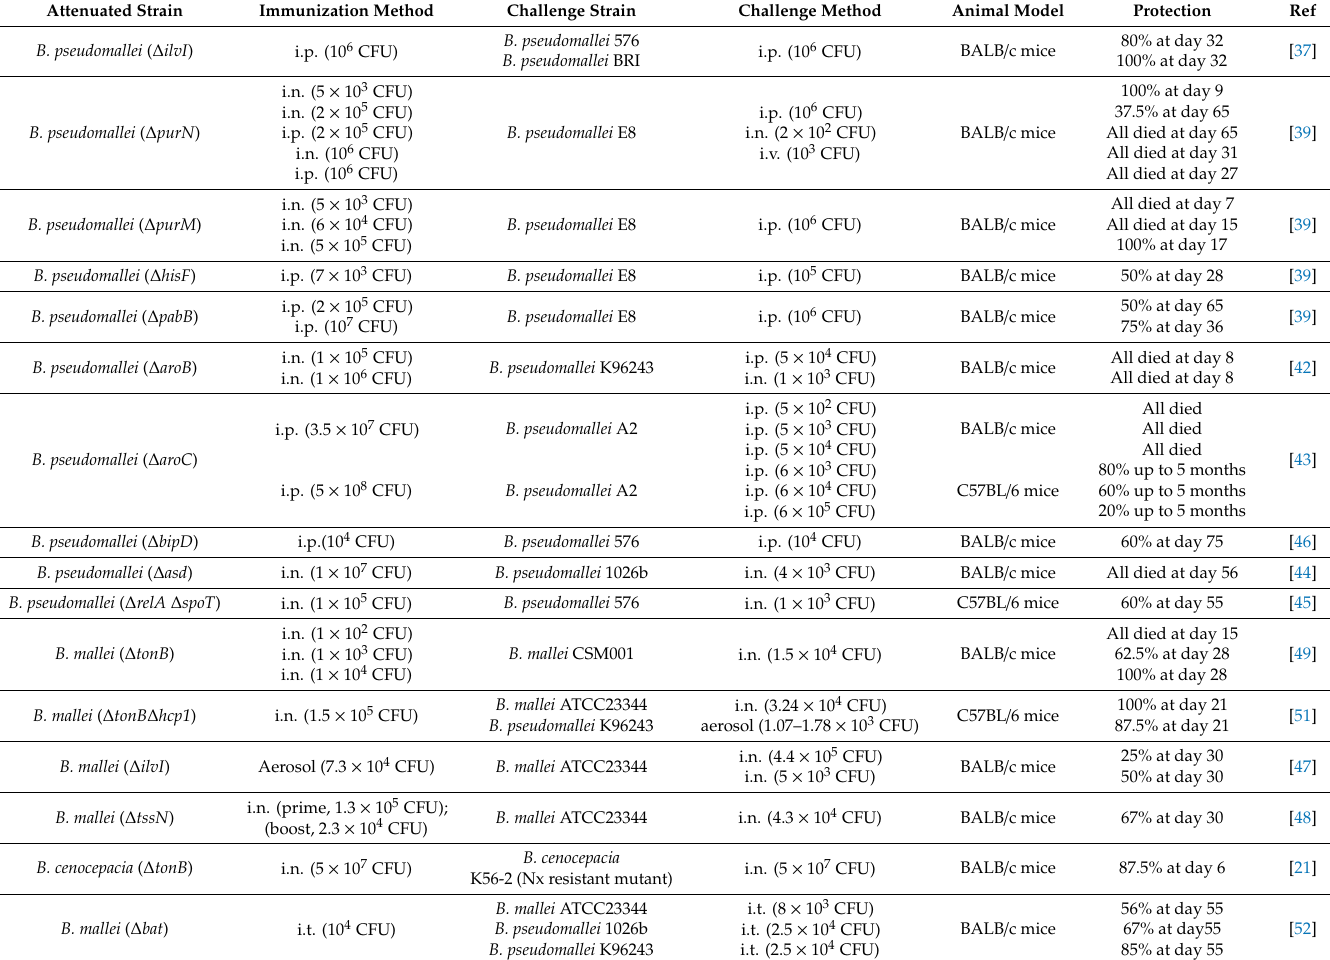
Table 2. Live-attenuated vaccines a